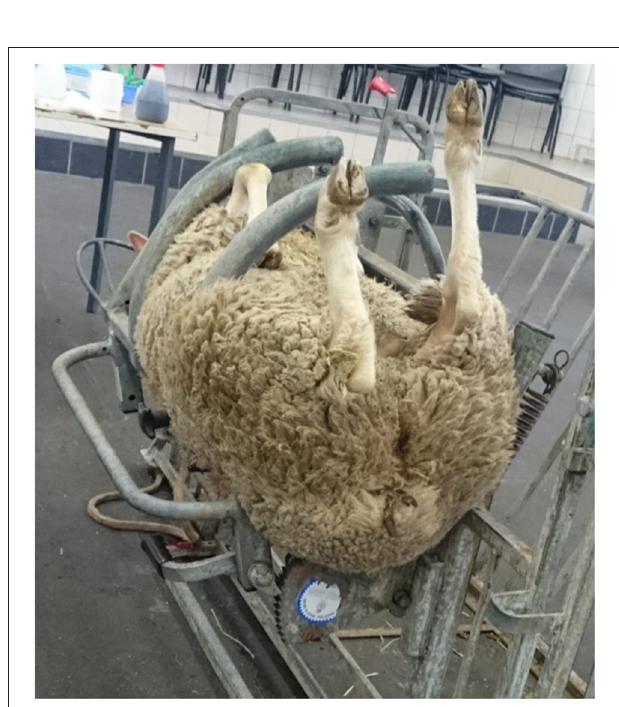
FIGURE 2 | Tilt table and positioning in dorsal recumbency of sheep during the